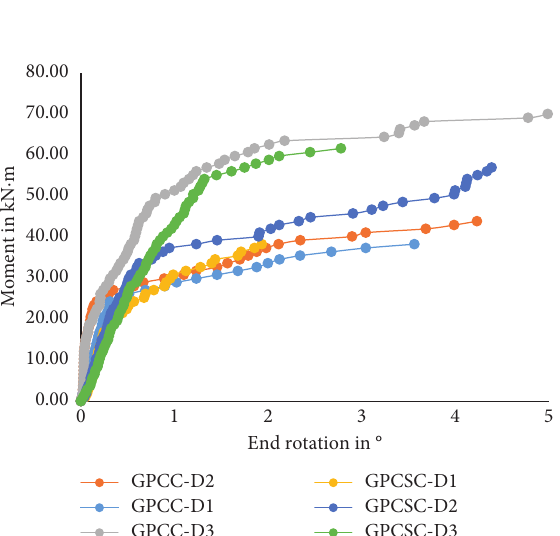
Figure 19: End rotation of SRB.